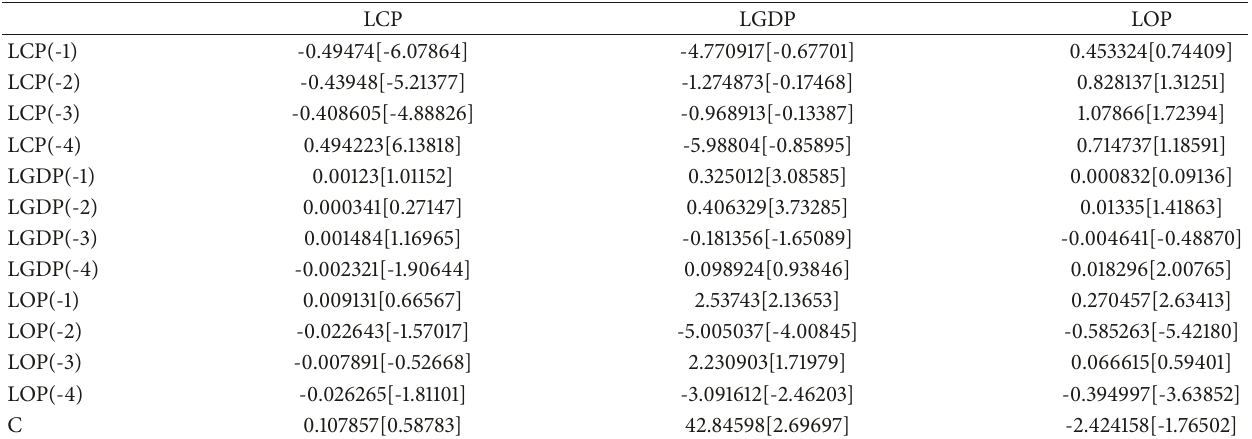
Table 4: Estimation results the VAR model.